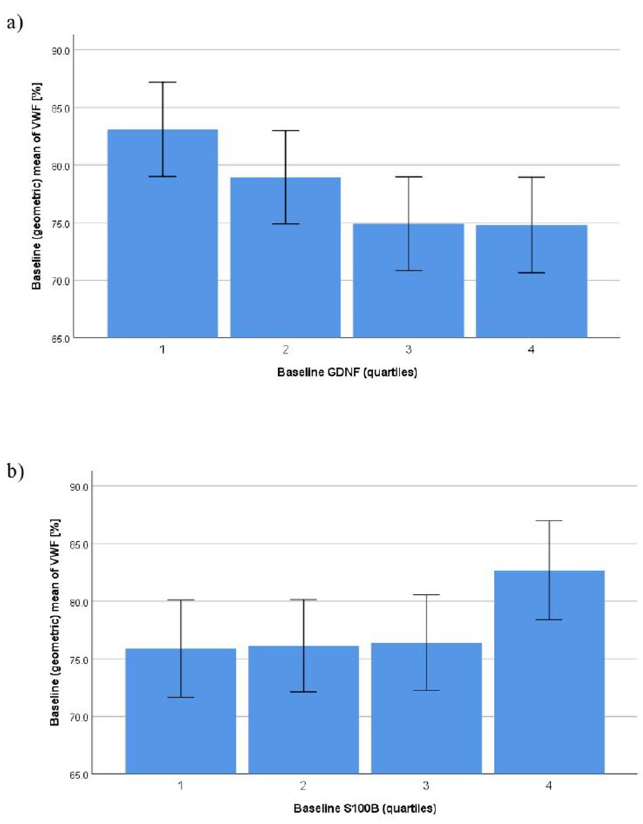
Figure 1. Fully adjusted significant associations between baseline values of neurotrophins across quartiles (1 = lowest quartile, 4 = uppermost quartile) and stress-induced percent changes in von Willebrand factor (VWF). GDNF, glial cell-derived neurotrophic factor; S100B, S100 calcium-binding